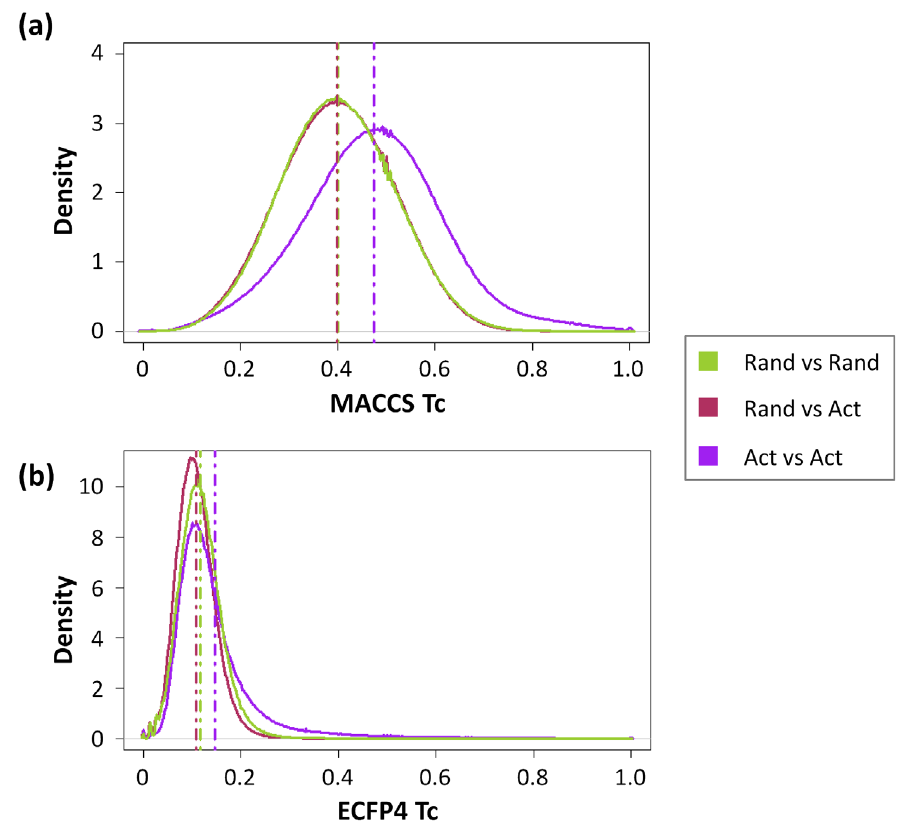
Figure 2. Distribution of combined similarity values. Density plots of Tc values are shown for similarity comparison using ( a ) MACCS and ( b ) ECFP4. Compared were active compounds in each activity class (Act vs Act, purple), 10,000 random ZINC compounds with each activity class (Rand vs Act, maroon), and 10,000 random compounds (Rand vs Rand, green). Similarity values of all 102 activity classes were combined. Dashed vertical lines indicate the means of the